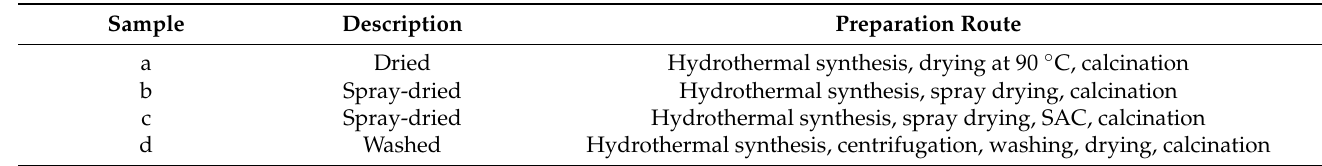
Table 2. Summary of the sequence of steps used to prepare calcined